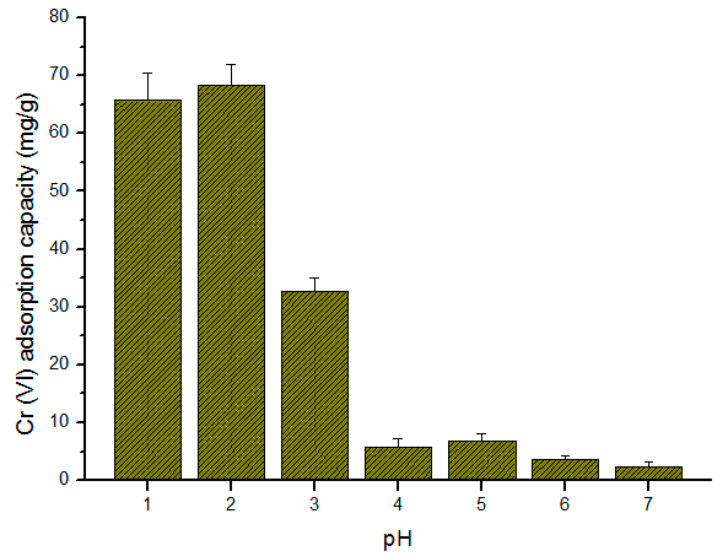
Figure 8. Effect of initial pH on the equilibrium Cr(VI) ion biosorption capacity of SS/KL blend beads (C 0 : 100 mg/L, adsorbent dose: 1.0 g/L, temperature: 25 °C, agitation rate: 180 rpm).